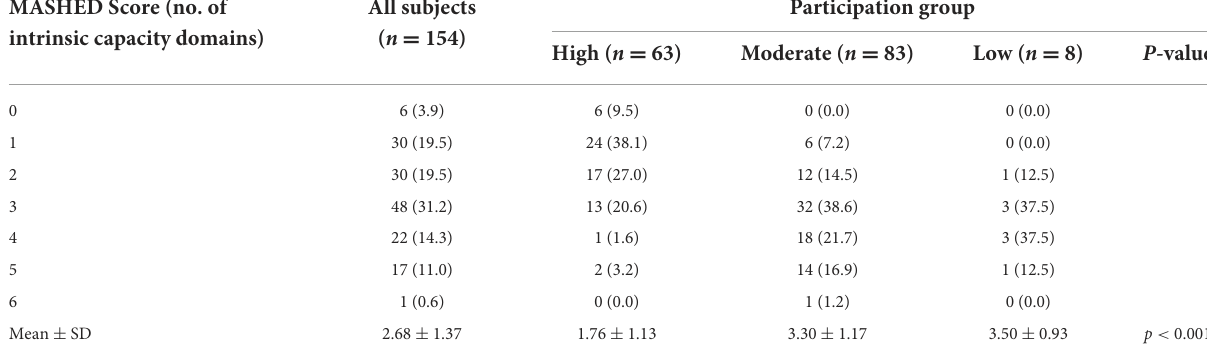
TABLE 6A MASHED score (from intrinsic capacity) and participation group. MASHED Score (no. of intrinsic capacity